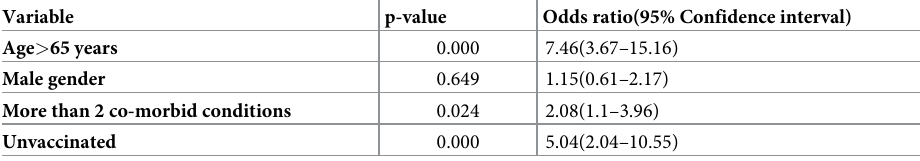
Table 8. Multi-variable regression analysis of predictors of